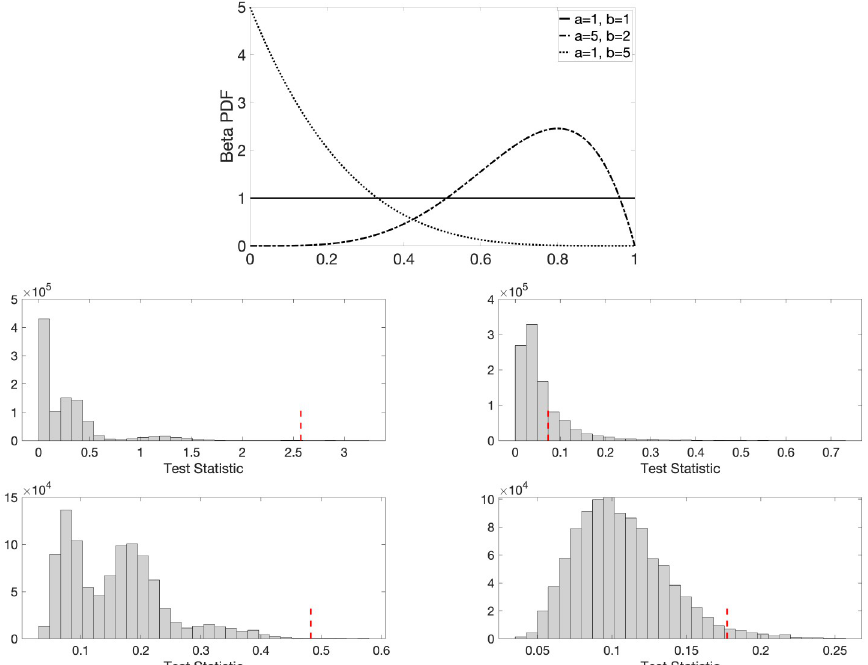
Fig 6. Top panel: Probability density functions of Beta(1, 1) or Uniform(0, 1) (in solid line), Beta(5, 2) (in dash-dotted line), and Beta(1, 5) (in dotted line). We sample the edge weights of random graphs from these three different distributions for validation purpose. Middle and bottom panel: Histogram plots of the ETL (middle) and maximum gap (bottom) test statistics and the corresponding observed test statistics (in dotted red lines) for the scenarios: Beta(1, 1) vs. Beta(5, 2) (left) and Beta(1, 1) vs. Beta(1, 1) (right) with 6 networks in each